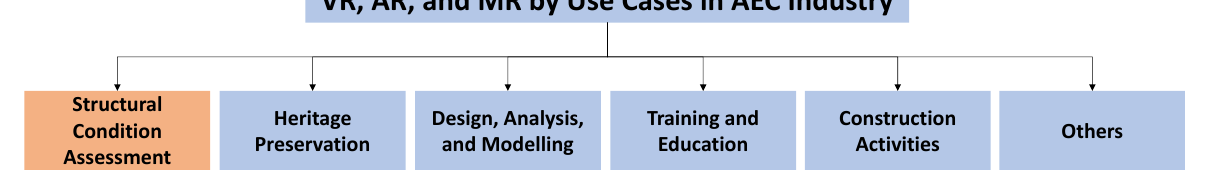
Figure 8. Use cases of VR, AR, and MR in the AEC Industry.